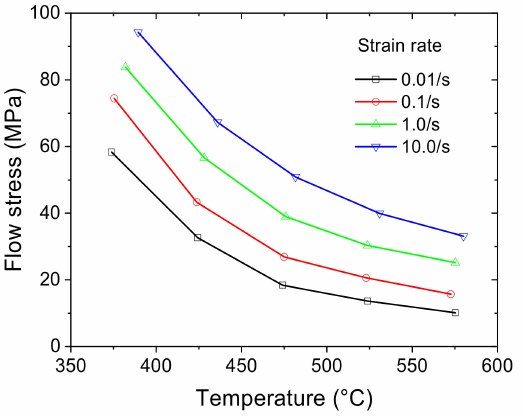
Figure 7. Influence of temperature on the measured flow stress of AA6061-T6 (true strain = 0.4).